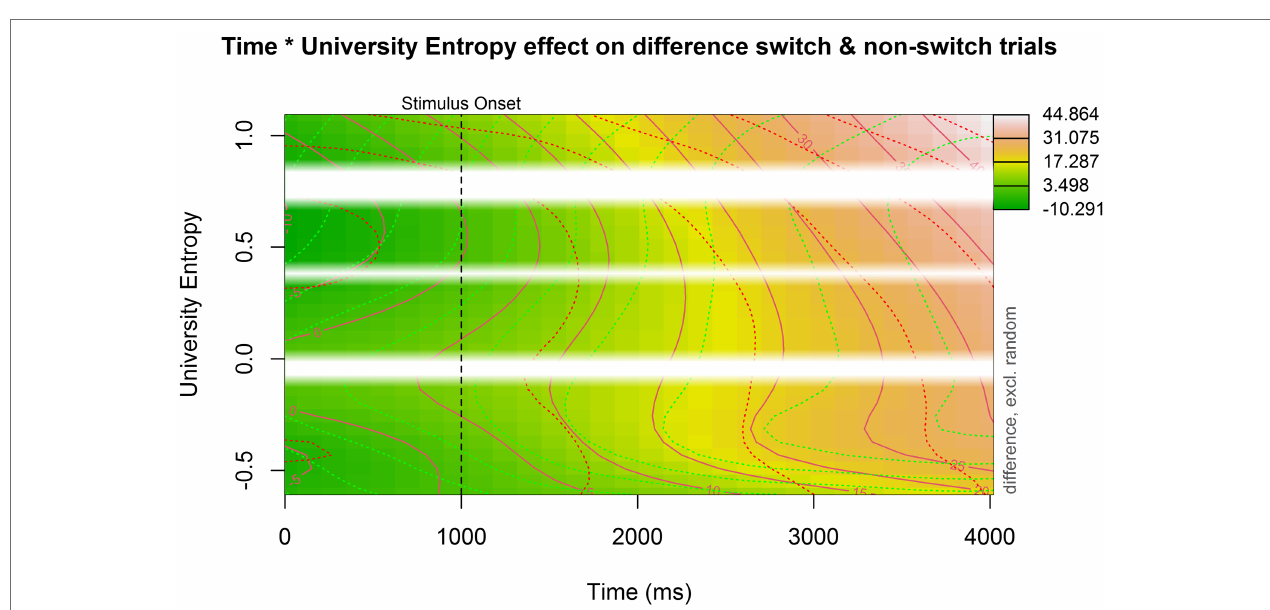
FIGURE 5 | Contour plot showing the interaction between university entropy, time, and the pupil switching cost (i.e., the difference in pupil size between switch and non-switch trials). Time is plotted on the x -axis, university entropy is plotted on the y -axis, and the pupil switching cost is indicated by color: darker green indicates a small or even reversed effect (where non-switch trials elicit a larger pupil dilation). The more red or even white the plot becomes, the larger the pupil switching cost. The white bars indicate missing data (i.e., non-existing entropy values in our